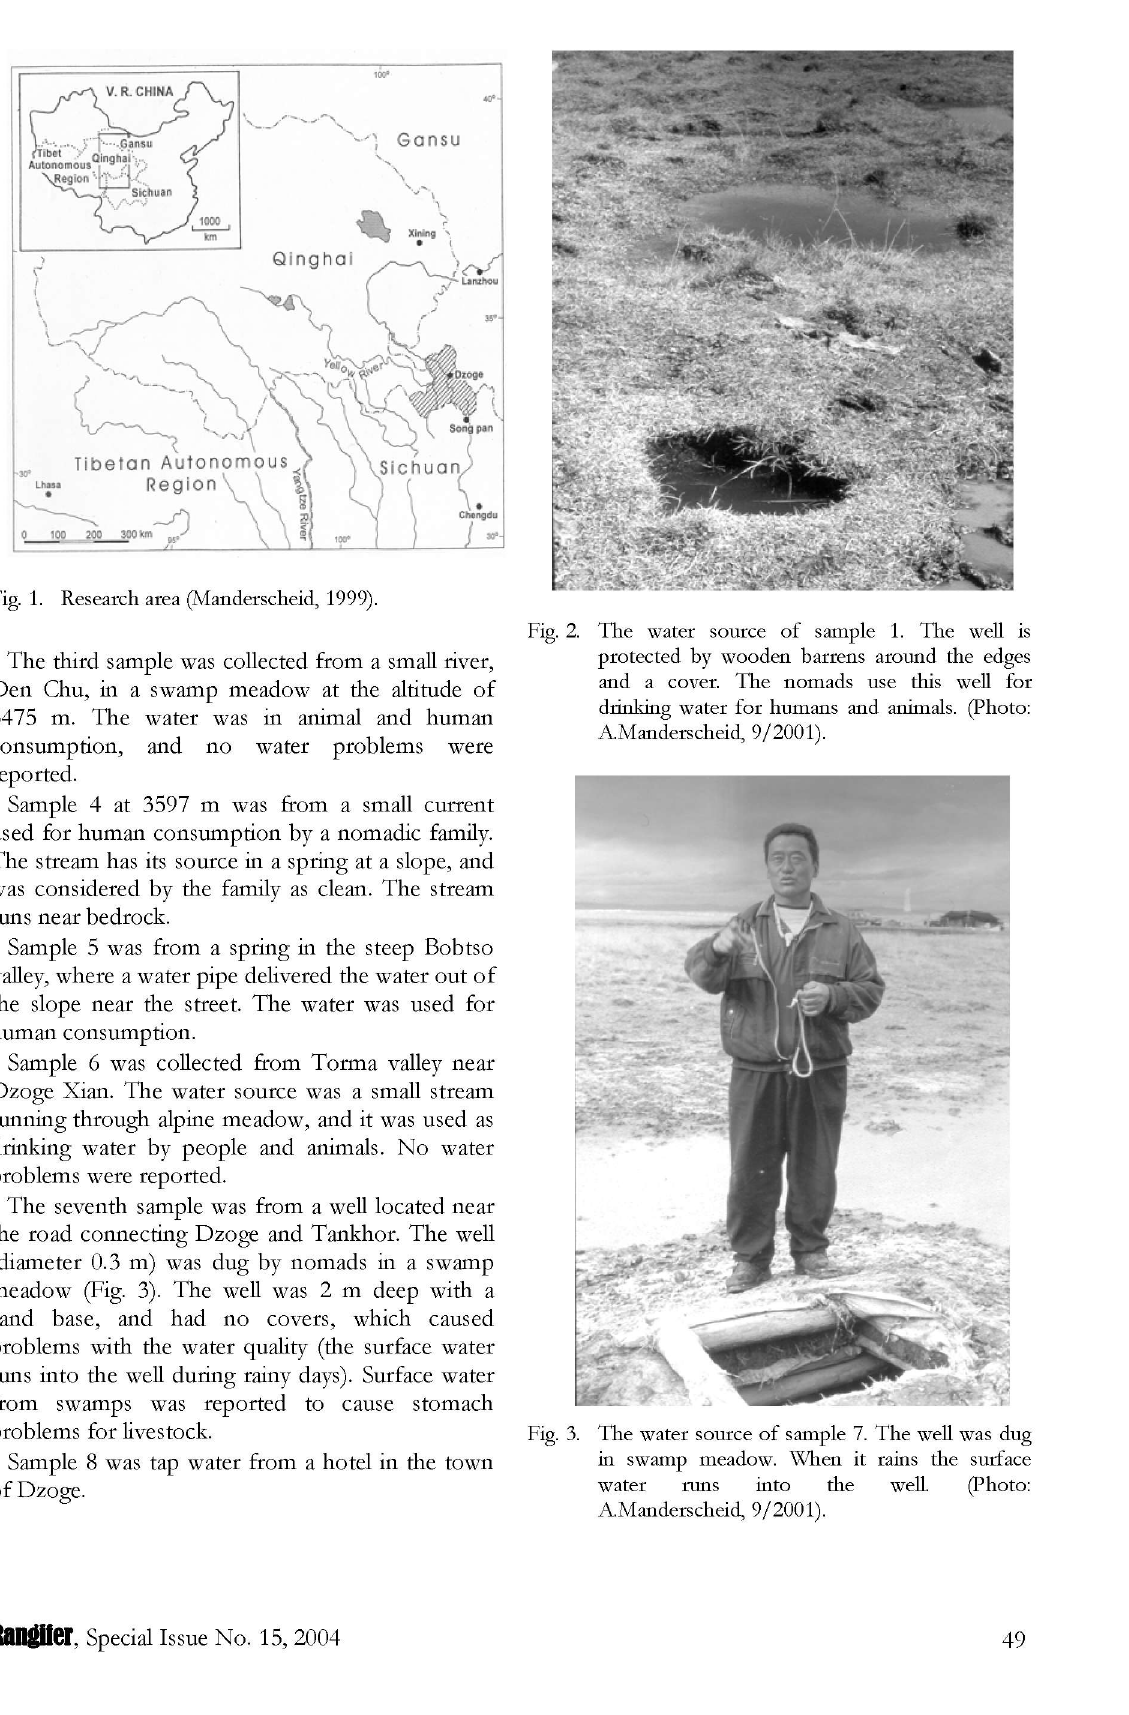
Fig. 1. Research area (Manderscheid, 1999).